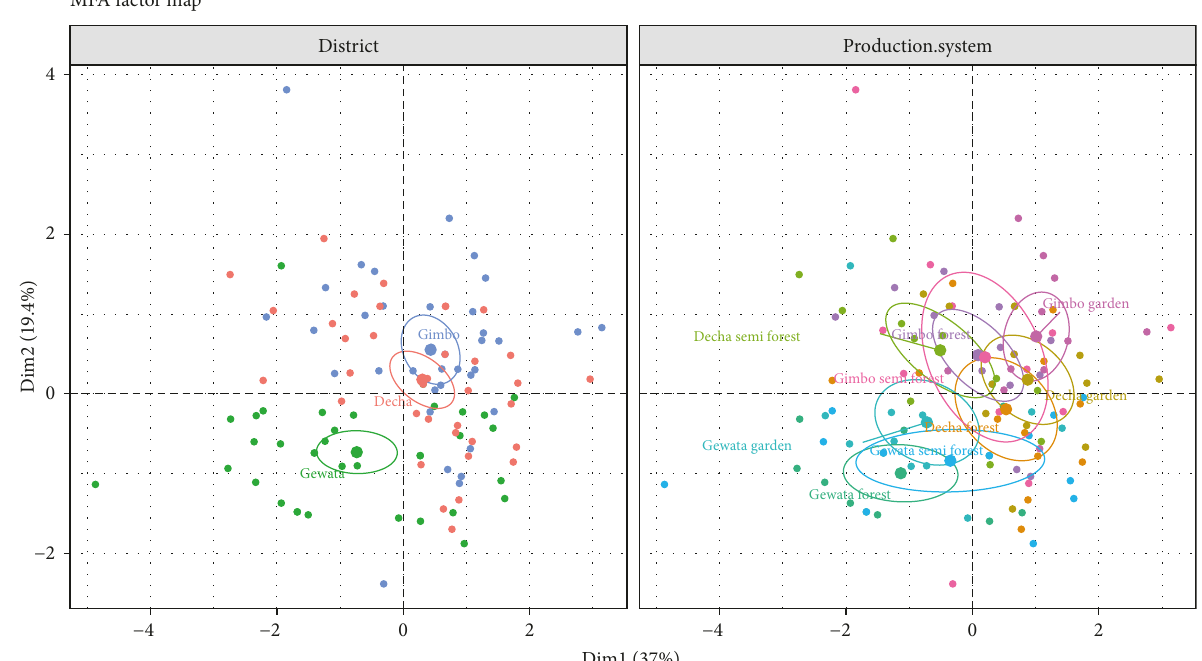
Figure 2: Individual coffee samples and their relationship with districts and production systems.